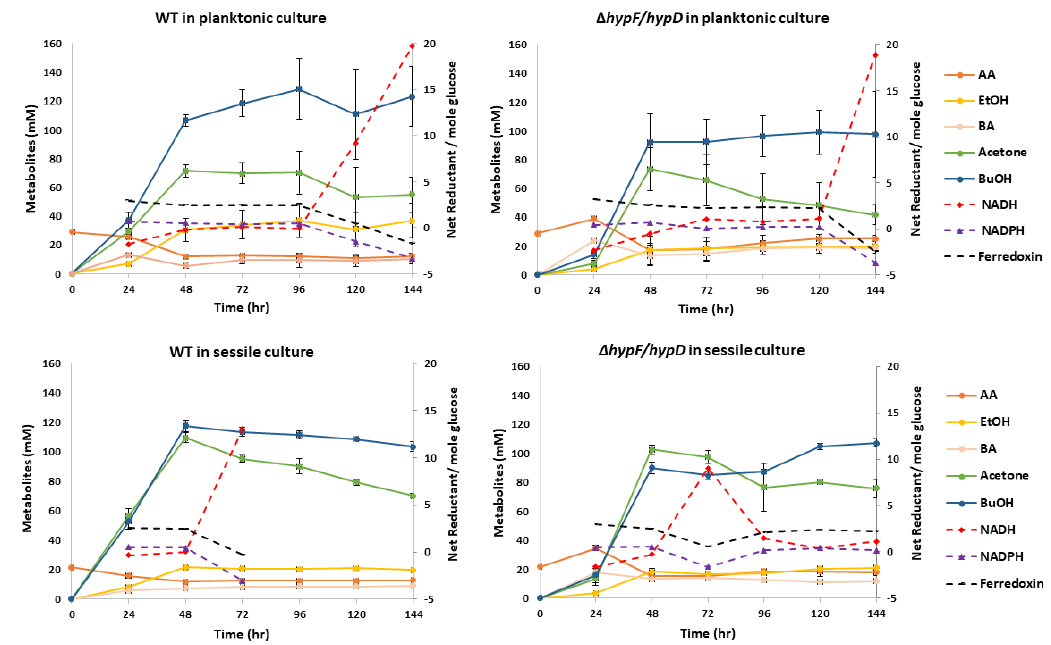
Figure 3. Metabolite profiles of planktonic and sessile cultures grown in minimal medium containing 6.0% glucose from an N = 3 experiment. Metabolite concentrations and calculated reduced cofactor formation vs. time for WT and ΔhypF / hypD cultures. The left Y axes correspond to metabolite concentrations in mM for acetate (AA), ethanol (EtOH), butyrate (BA), acetone, and butanol (BuOH). The right Y axes correspond to calculated reduced cofactors (NADH, NADPH, and ferredoxin) formed from consumption/production of acetyl-CoA calculated from changes in metabolite concentrations from the previous time point. Total calculated reduced cofactors were normalized to glucose utilization for the same time period and expressed as net reductant/mol glucose. These calculations are not included for time points after glucose utilization ceased.